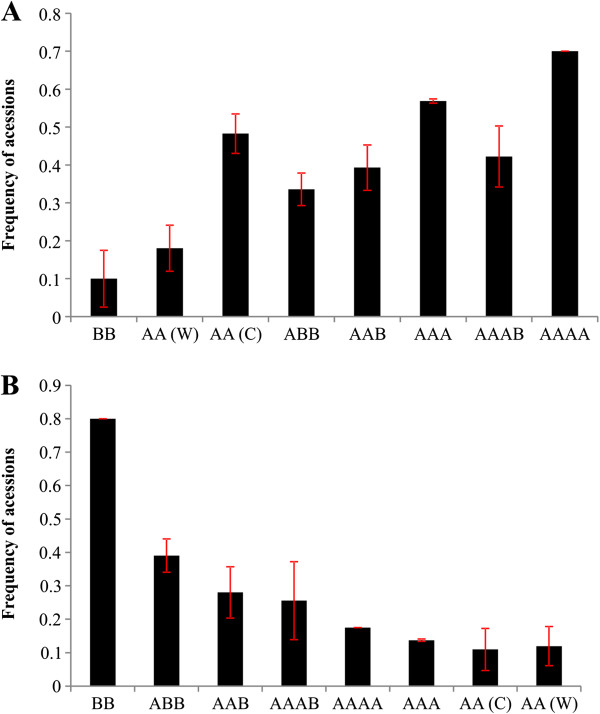
Frequency distribution of the 20 most frequent alleles in cultivated diploid accessions AA(C) (panel A) and BB (panel B) in comparison with other genomic groups. W: wild; C: cultivated. The errors bars refer to the ratio of accessions that did not amplify one or more analyzed loci.